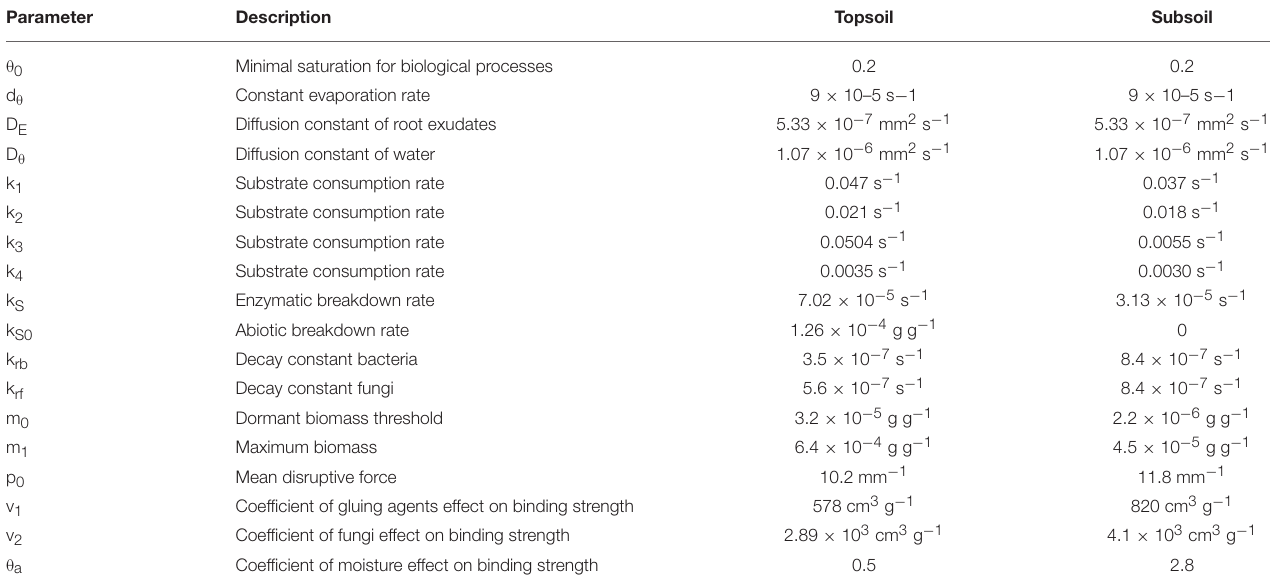
TABLE 2 | Model parameter estimates.